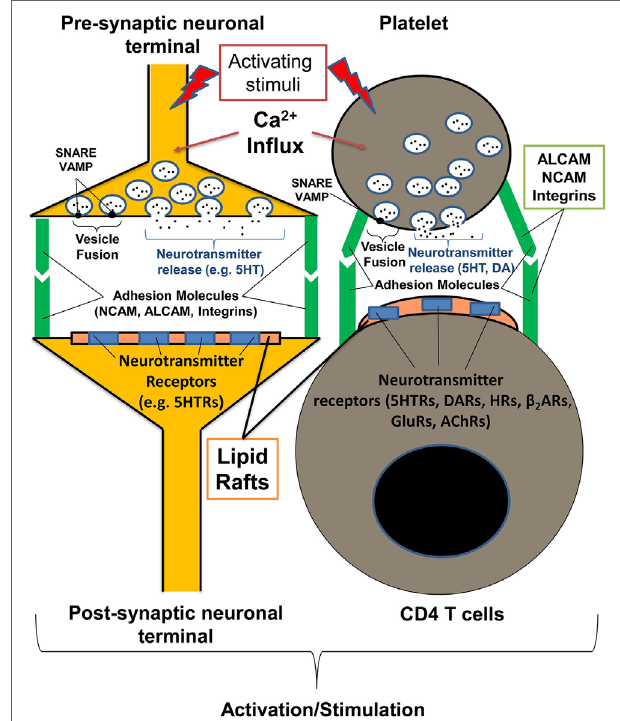
FigURe 1 | Communication of platelets with CD4 T cells has many similarities with the interaction of presynaptic and postsynaptic neurons. The process of platelet degranulation is very similar to the process of the release of neurotransmitters by presynaptic neurons. In both presynaptic neurons and platelets, neurotransmitters (e.g., serotonin, dopamine), and other mediators are stored in specific vesicles inside the cells. During the process of neuronal or platelet activation, specific vesicles are fused with the surface membrane (using the same docking molecules for platelets and neurons such as VAMP and SNARE), and the vesicle content is released. Both CD4 T cells and postsynaptic neurons have detergent-resistant membrane domains (lipid rafts) with neurotransmitter receptors (e.g., serotonin, dopamine receptors) that promote the further activation of postsynaptic neuron or T cells when stimulated. Both neuronal and platelet–T cell synapses are stabilized with adhesion molecules such as ALCAM, NCAM, and various integrins. ACLAM adhesion molecules and integrins are expressed by neurons, platelets, and activated T cells, and NCAM is expressed by neurons and subsets of activated T cells. During inflammation, platelets are able to directly interact with postsynaptic neurons or activate T cells recognizing specific glycolipids (sialylated gangliosides) and glycoproteins (ALCAM, NCAM) within lipid rafts via specific receptors (CD62P, Siglecs, CLRs). AChRs, acetylcholine receptors; CLRs, C-type lectin receptors; DA, dopamine; DARs, dopamine receptors; GluRs, glutamate receptors; HRs, histamine receptors; β 2 ARs, β 2-adrenoreceptors; 5HT, serotonin; 5HTRs, serotonin